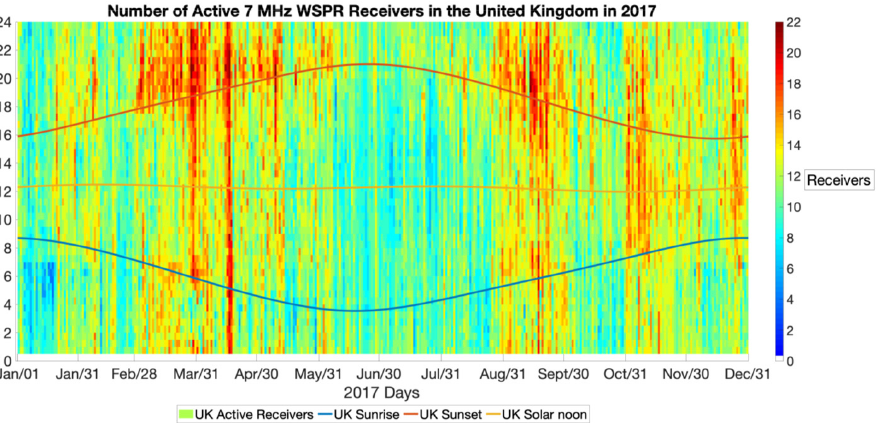
Figure 7. Number of active UK WSPR receivers in 2017. Only receivers with a proven capability to cover the distance from New Zealand to the UK are shown. The colours indicate the number of receivers available in each half-hour interval.